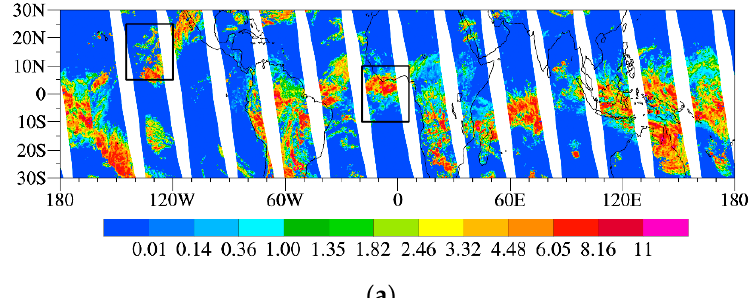
( a ) Figure 12. Cont